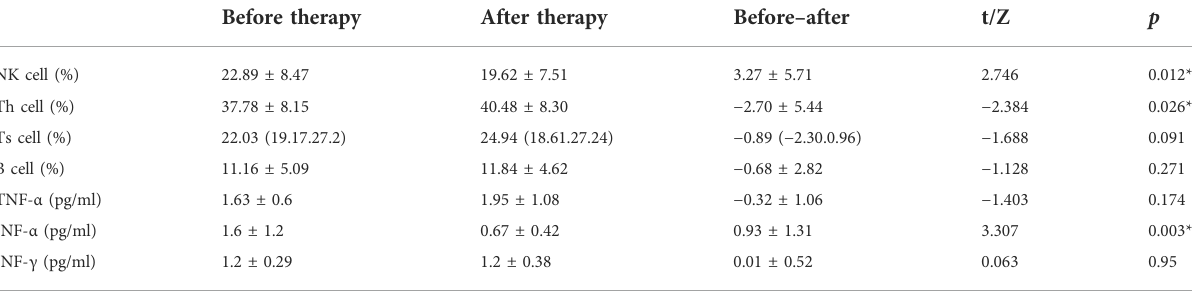
TABLE 8 Changes of lymphocyte subsets of SARS-CoV-2-infected patients (x ± s ). (X is the average value, i.e., X bar, and a horizontal line should be added at the top of X. Before therapy After therapy Before – after t/Z p